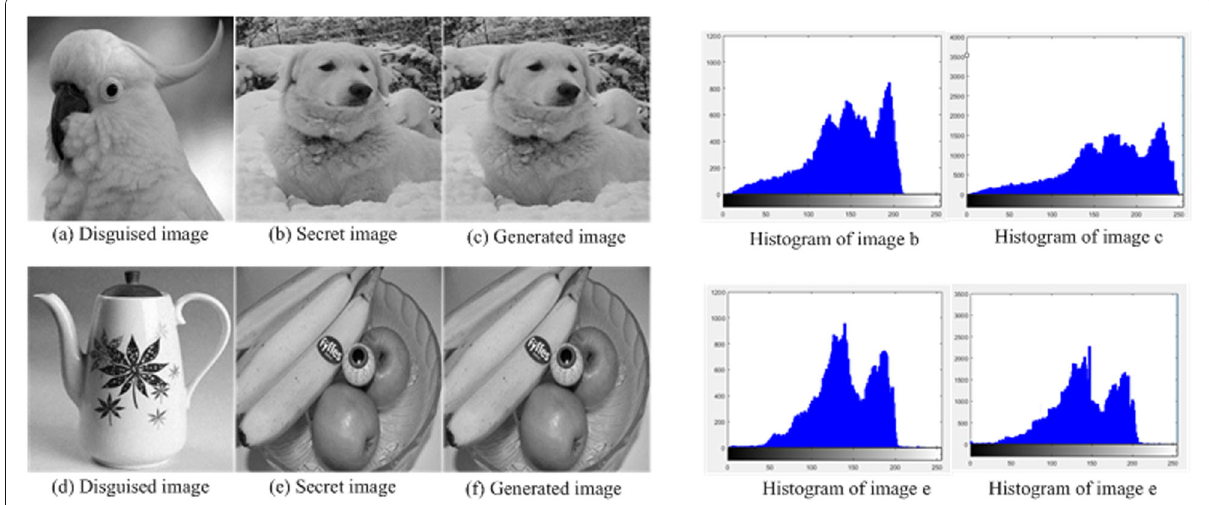
Fig. 9 Two examples on the ImageNet